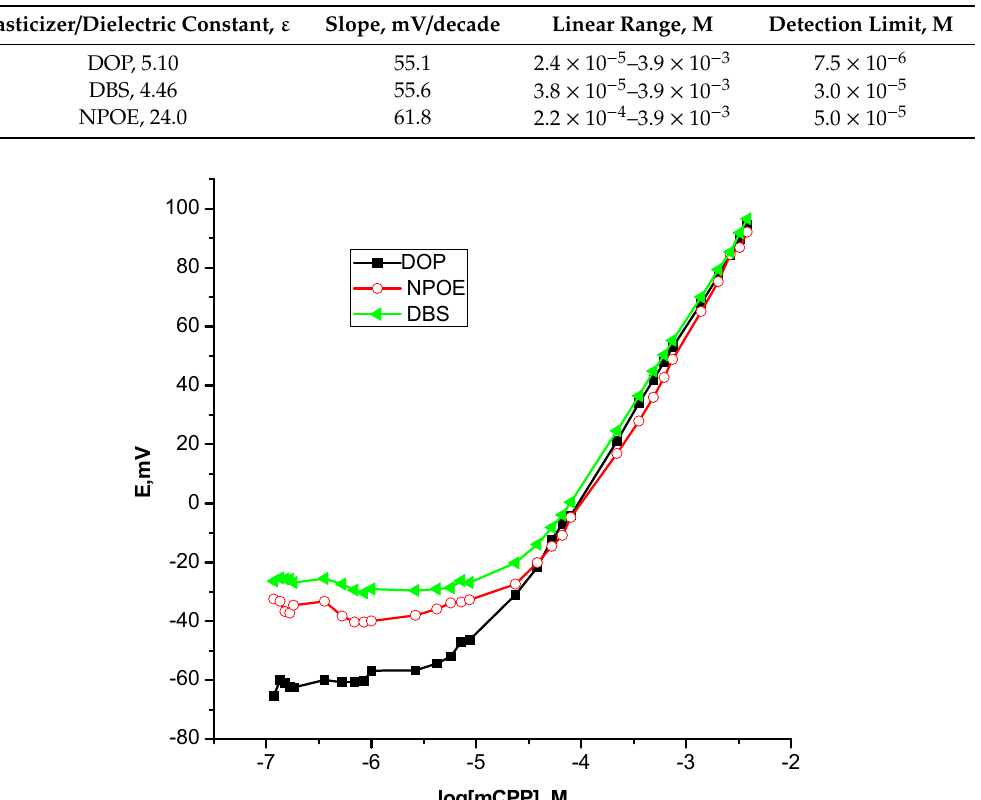
Figure 4. E ff ect of plasticizers on the performance of m-chlorophenylpiperazine polymeric membrane Figure 4. Effect of plasticizers on the performance of m-chlorophenylpiperazine polymeric based membrane based sensors.